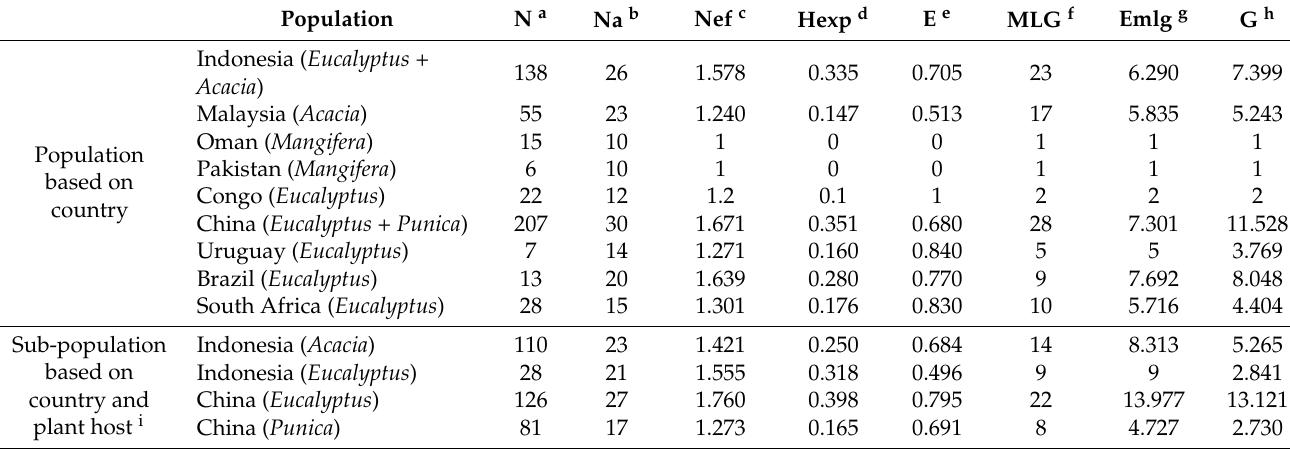
based on country and plant host i